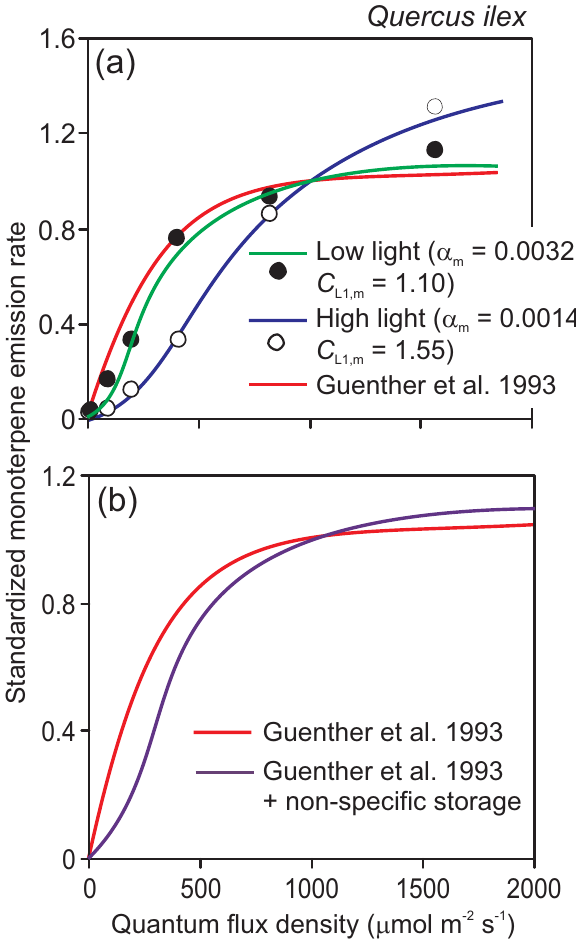
Fig. 5. Light-responses of monoterpene emission rate in the Mediterranean evergreen sclerophyll Quercus ilex grown under high and low light and comparison with Guenther et al. (1991) standard emission response (Eq. 2) (a) (data from Staudt et al., 2003), and (b) simulated responses of monoterpene emissions using a steady- state algorithm (Guenther et al., 1993) and a dynamic algorithm that considers the effect of non-specific storage on monoterpene emis- sions (Eq. 8; Niinemets and Reichstein, 2002). In the dynamic sim- ulation, the synthesis rate of monoterpene emission at any light in- tensity was predicted by Guenther et al. (1993) algorithm, and the light level was increased by 50µmolm − 2 s − 1 steps in every 2min. In (a), the data were fitted by modified light-response function sug- gested by Schuh et al. (1997; Eq.